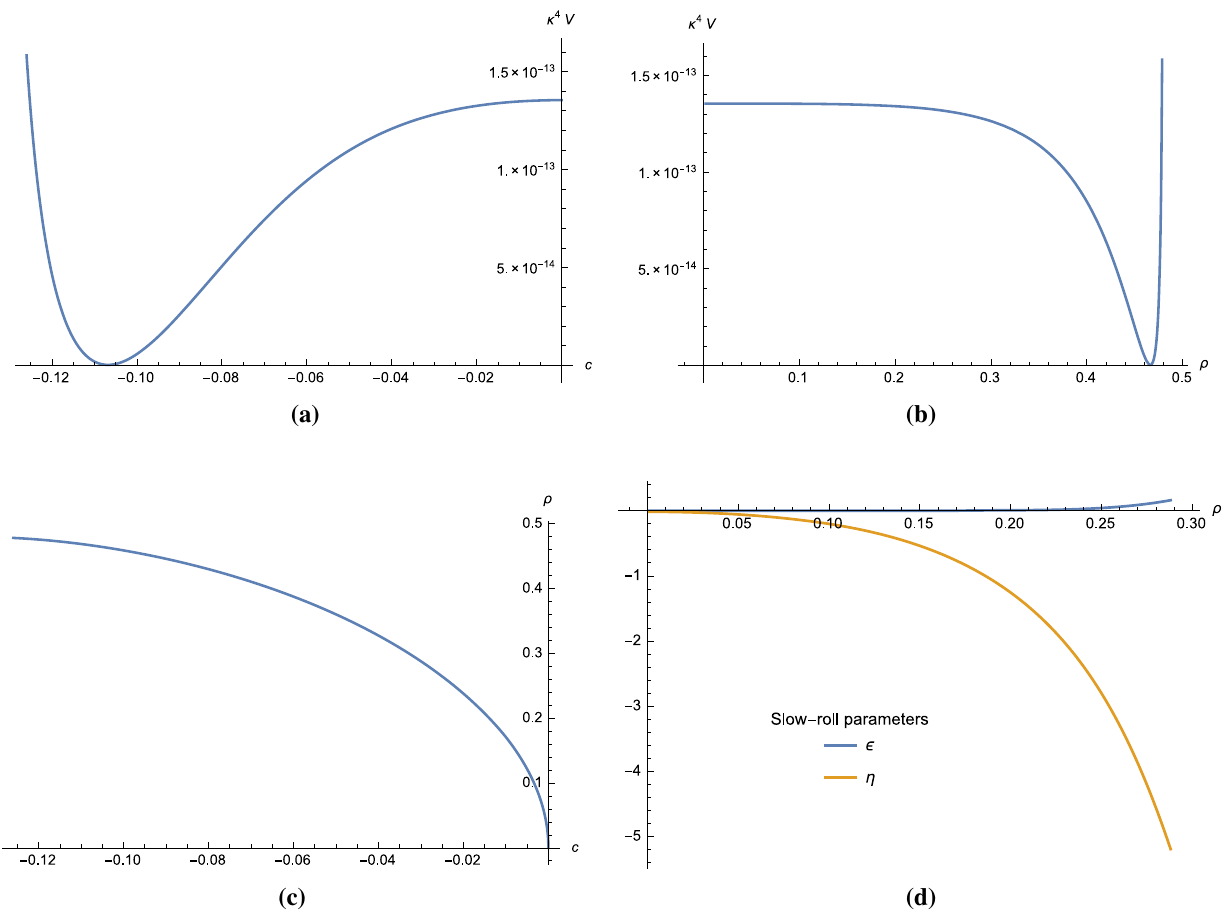
Fig. 4 Plots of the scalar potential in Region III of Fig. 1 with parameters (5.33) as a function of the coordinate c in a and ρ in b . The relation between ρ and c is plotted in c . The slow-roll parameters (cid:9) and η are shown in